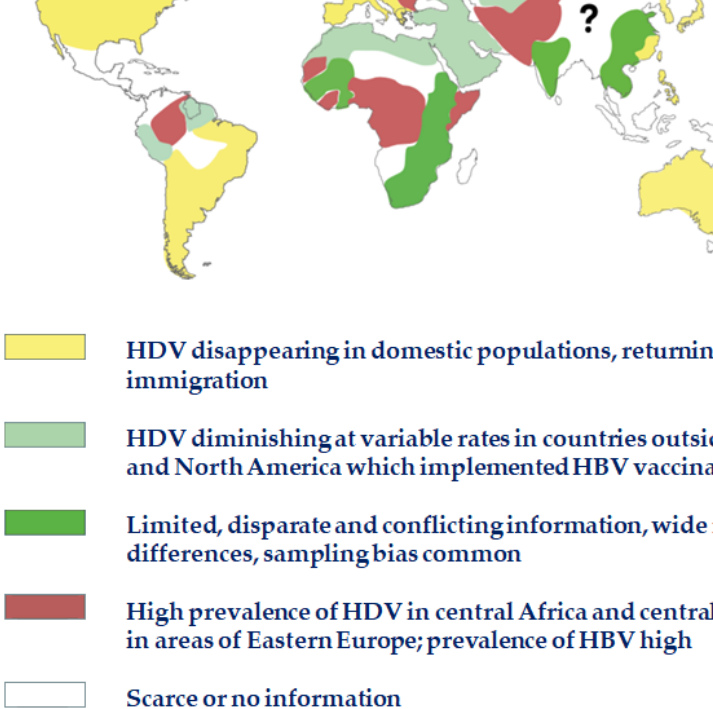
Figure 4. Contemporary HDV prevalence. Abbreviations: HBV, hepatitis B virus; HDV, hepatitis D virus.